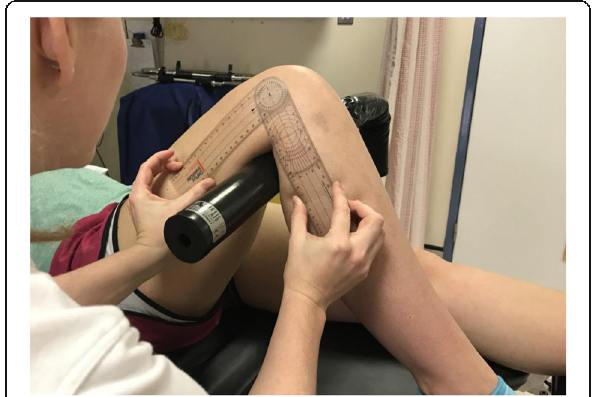
Fig. 1 Use of a short arm goniometer for knee angle measurement (subject supine on an operating table with a 90 degree support under the